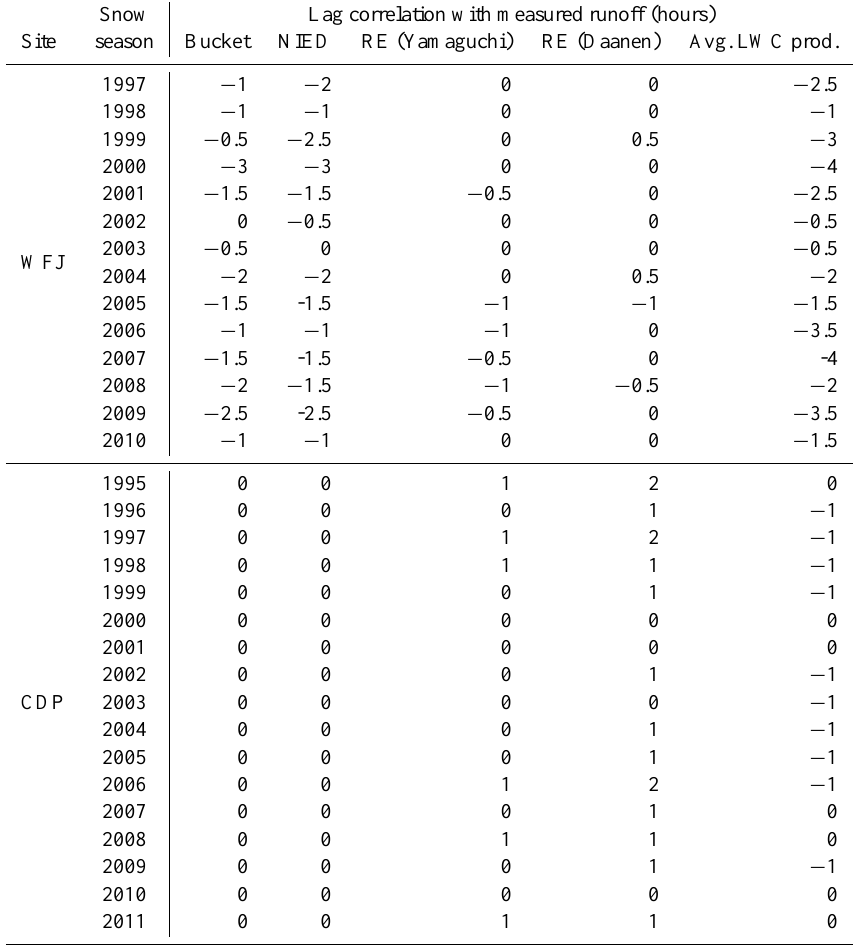
Table 2. Lag correlation coefficients (hours) for modelled snowpack runoff compared to measured snowpack runoff. Negative values mean the measured snowpack runoff should be shifted back in time to match modelled snowpack